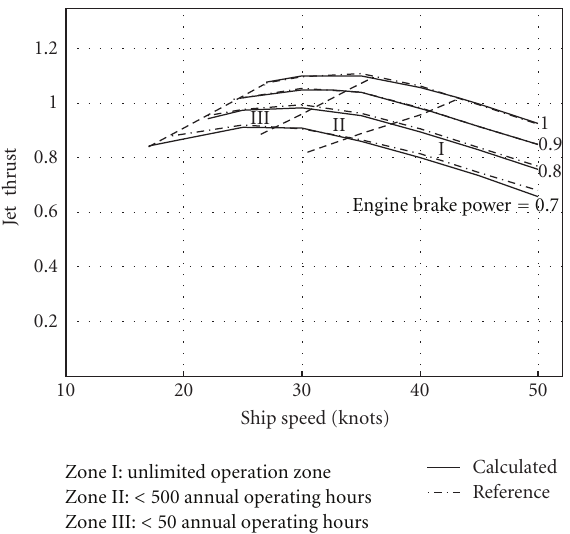
Figure 16: Thrust versus ship speed waterjet